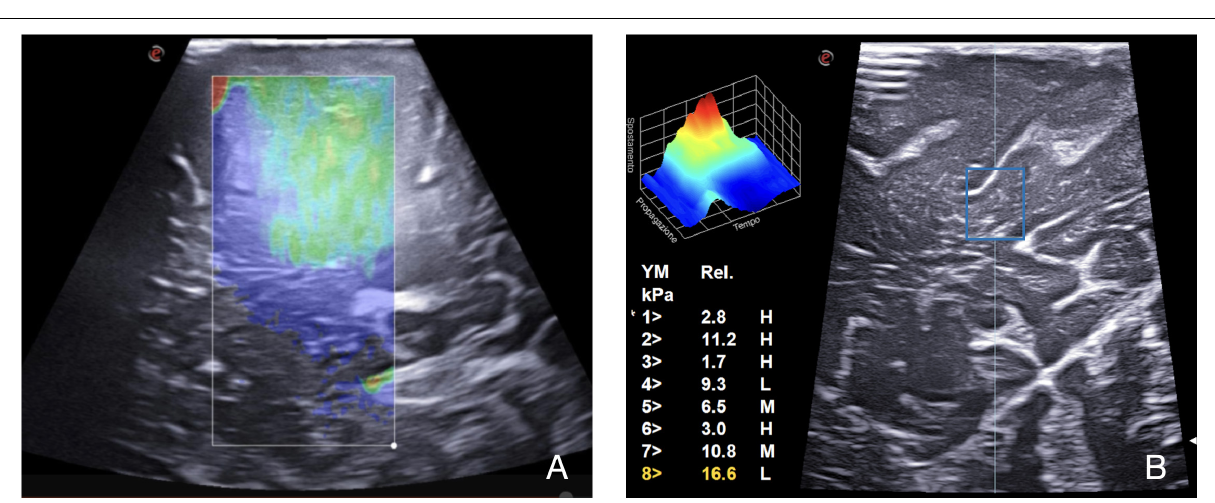
FIGURE 4 | SE and SWE. Elastosonography provides information regarding the tumor and surrounding parenchyma mechanical properties through qualitative and quantitative evaluation. (A) On the left, SE in a case of metastasis: a mechanical force is applied to measure lesion stiffness, which is expressed on a color scale for qualitative assessment. (B) On the right, SWE, using the QElaxto algorithm, provides a quantitative assessment of stiffness of a specific ROI inside the